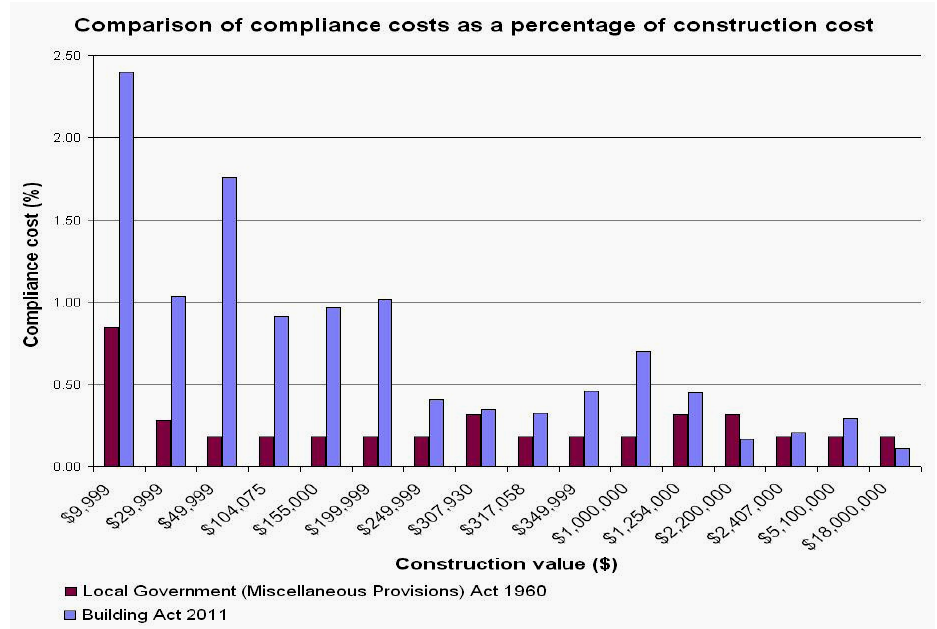
Figure 3 Comparison of compliance costs under the Local Government (Miscellaneous Provisions) Act 1960 and the Building Act